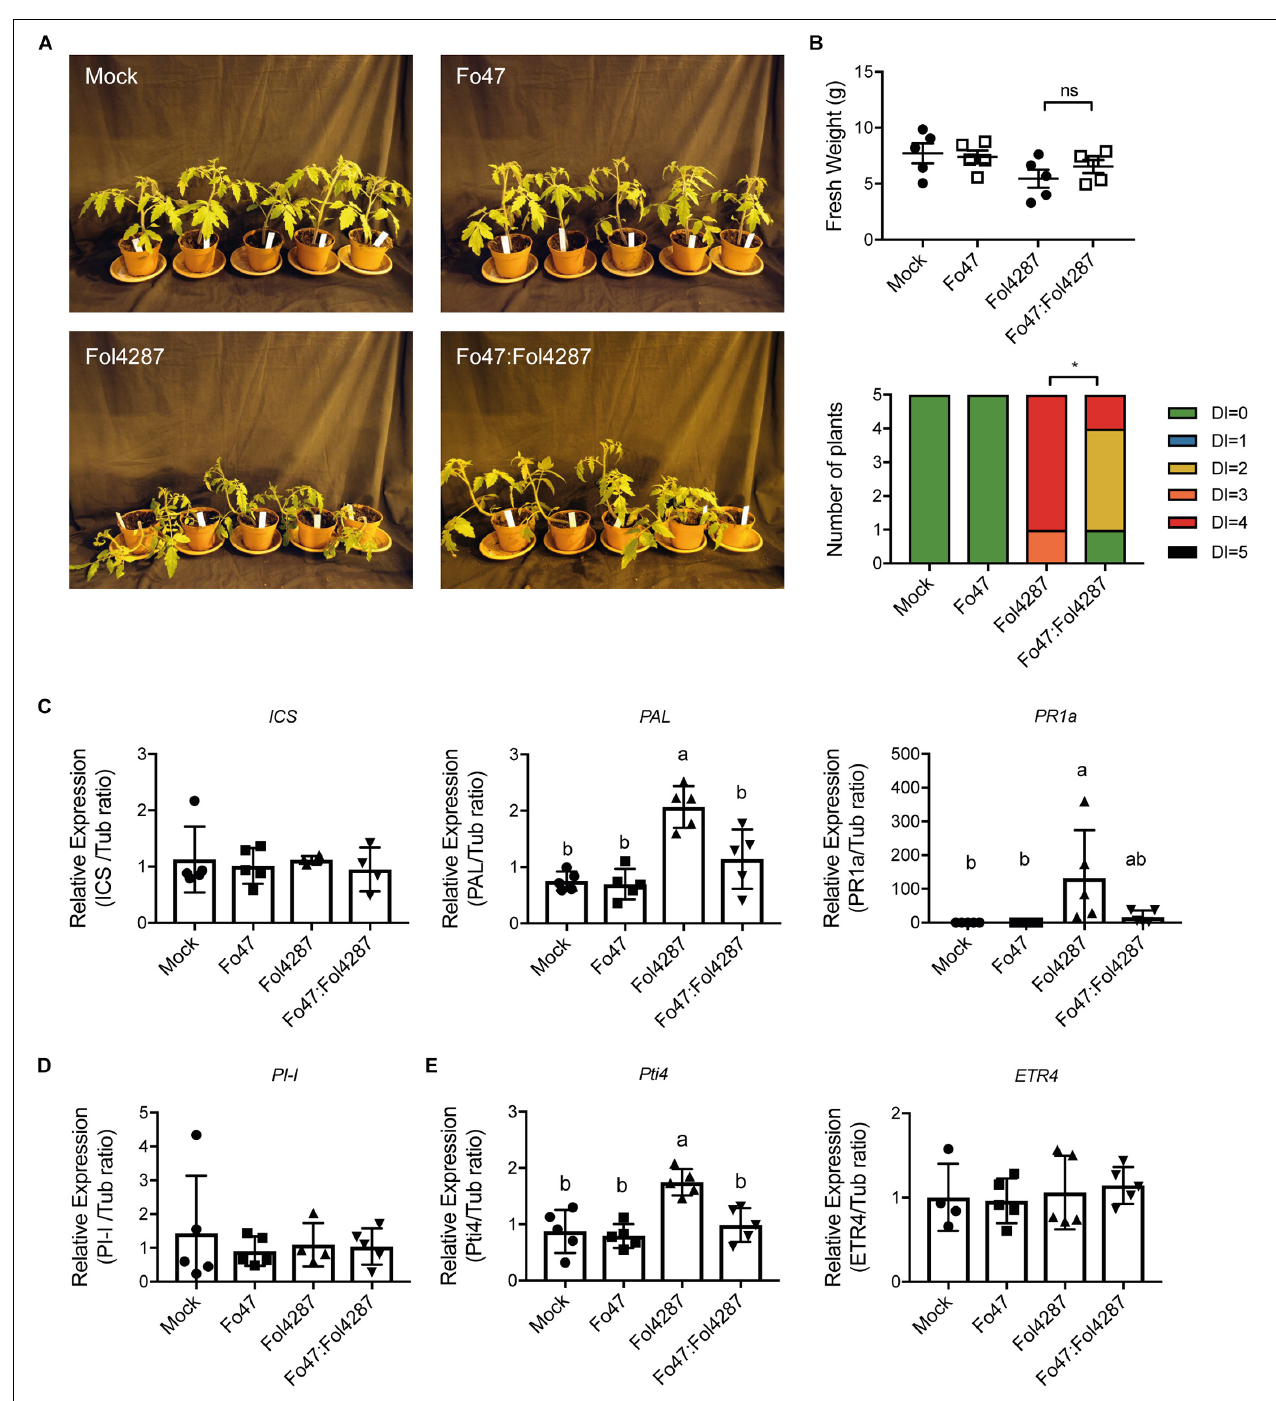
FIGURE 1 | Expression of SA, JA, or ET marker genes is unaffected by EMR. (A) Ten days old wild-type tomato seedlings (C32) inoculated with water (mock), Fo47, Fol4287 or co-inoculated with Fo47 and Fol4287. (B) Disease development as assessed by measuring fresh weight and disease index 3 weeks after inoculation. Raw data was analyzed by a non-parametric Mann–Whitney U -test ( ns P > 0.05, ∗ P < 0.05). (C) Expression levels of the SA biosynthesis genes isochorismate synthase ( ICS ) and phenylalanine ammonia-lyase ( PAL ) or the pathogenesis-related 1a ( PR1a ) SA maker gene in Fo47, Fol4287 or in co-inoculated plants. (D) Expression levels of the JA reporter gene proteinase inhibitor ( PI-I ) in Fo47, Fol4287 or in co-inoculated plants. (E) Expression levels of the ET-regulated marker genes ethylene responsive factor ( Pti4 ) and ethylene receptor ( ETR4 ) in Fo47, Fol4287 or in co-inoculated plants. Gene expression levels were measured using RT-qPCR and depicted relative to that of tubulin . Five biological replicates per each treatment were analyzed. The different letters represent a significant difference at P < 0.05 as determined by ordinary one-way ANOVA with Tukey’s multiple comparisons test. A repetition of this experiment is shown in Supplementary Material .